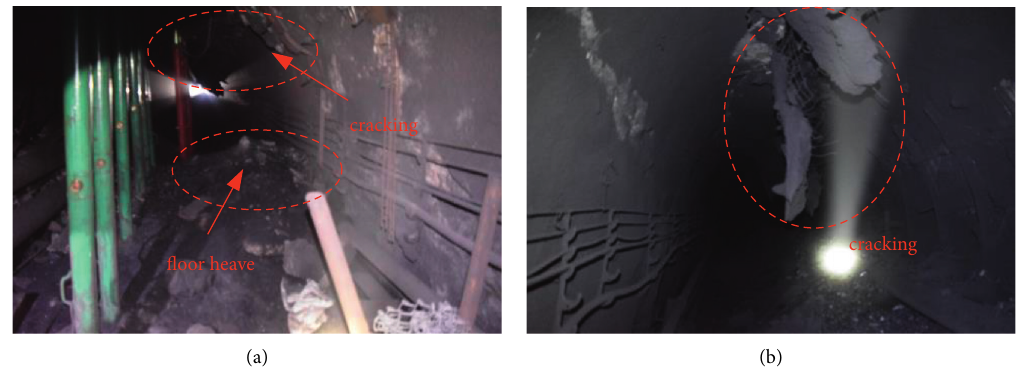
Figure 3: Actual photo of the return roadway: (a) schematic diagram of sidewalls of the roadway sideways and floor heave; (b) schematic diagram of roadway roof